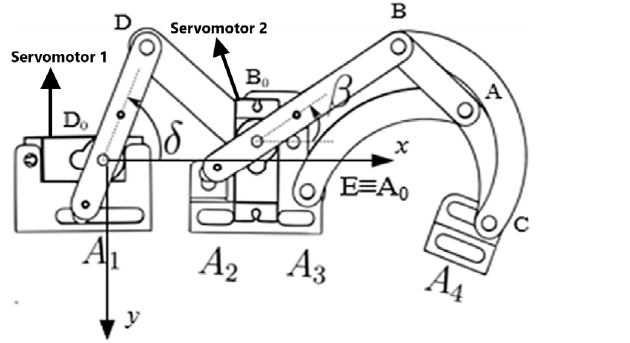
Figure 2. The proposed finger exoskeleton: ( a ) CAD design [28]; ( b ) an experimental setup. Servomotor 2 also controls an angular position β with the horizontal axis as a reference, as shown in Figure 2a. The servomotor 2 produces a maximum torque of 0.18 N-m as T2 in a clockwise direction, represented in Figure 1. The dimensions of the exoskeleton are tabulated in Table 1. Table 1. Design parameters and dimensions of the proposed finger exoskeleton [28].